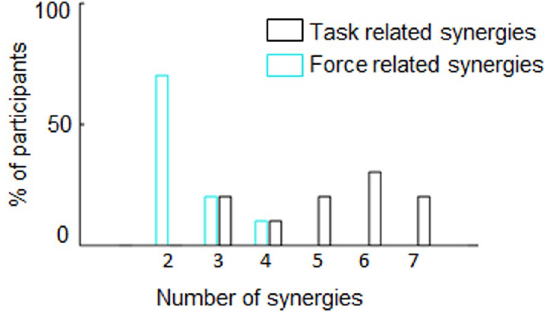
Figure 3. Number of synergies composing the task- and force-related subset. Across-participants (n = 10) frequency distribution of the number of muscle synergies composing the task-related subset (black) and force- related subset (cyan). The task-related subset is composed of the least number of muscle modules reconstructing over 90% of the whole EMG dataset variance. The force-related subset is composed by the smallest set of muscle synergies modules significantly related to the external force (GLMM analysis).